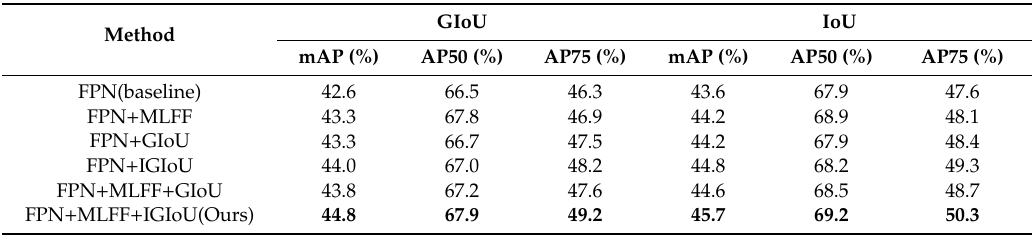
Table 3. Comparison with baseline methods on the DIOR dataset in terms of six evaluation metrics. Bold fonts denote the best results.